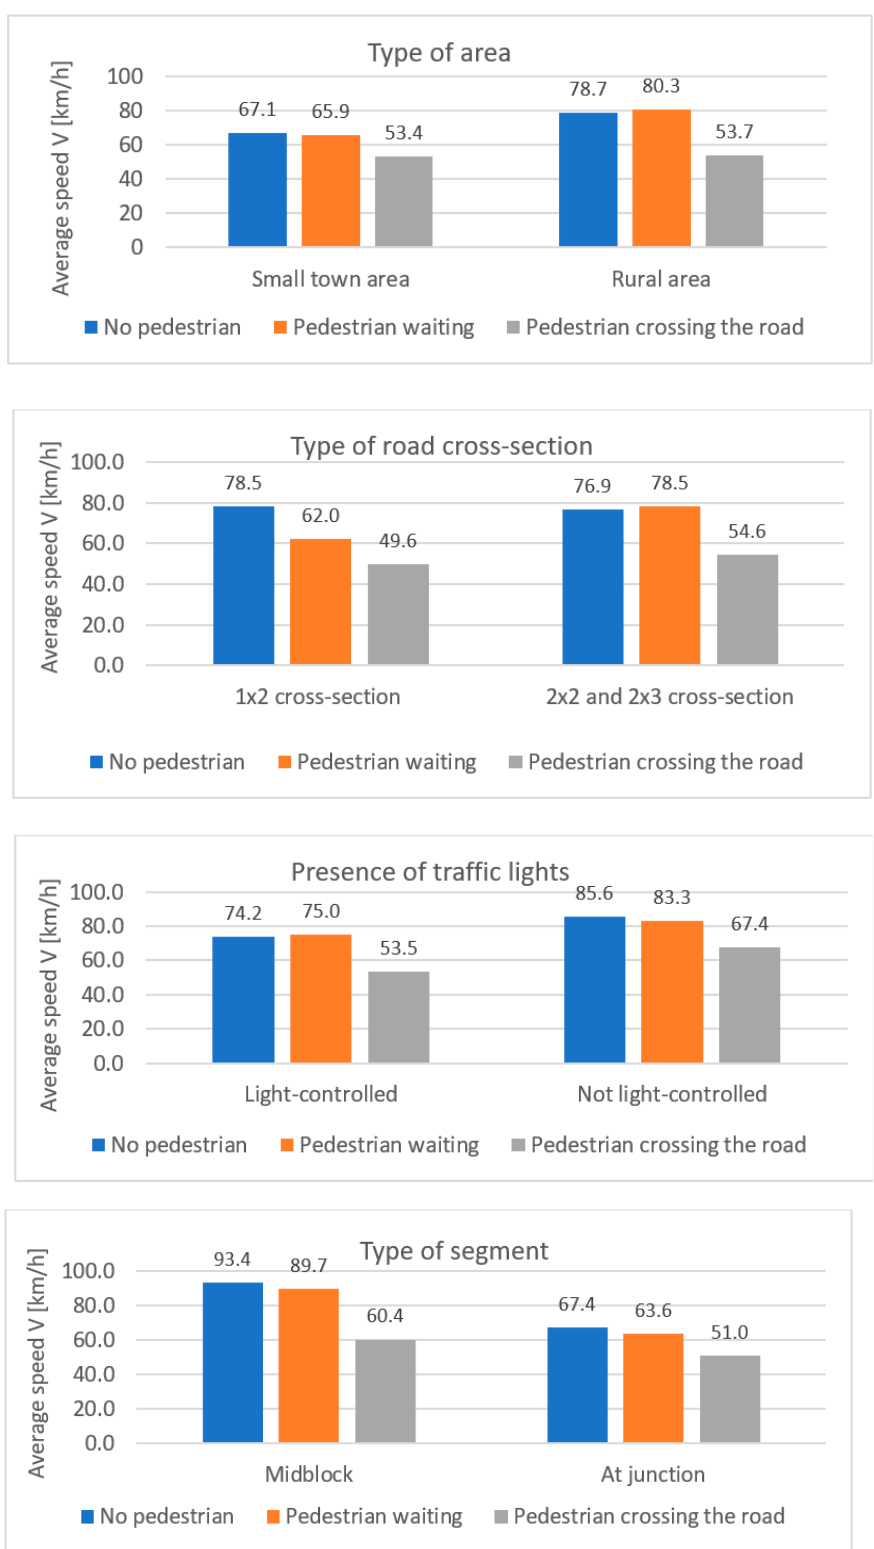
Figure 7. Comparison of speeds at pedestrian crossings in selected locations—speed limit of 70 km/h (measured at 70 m from the crossing).